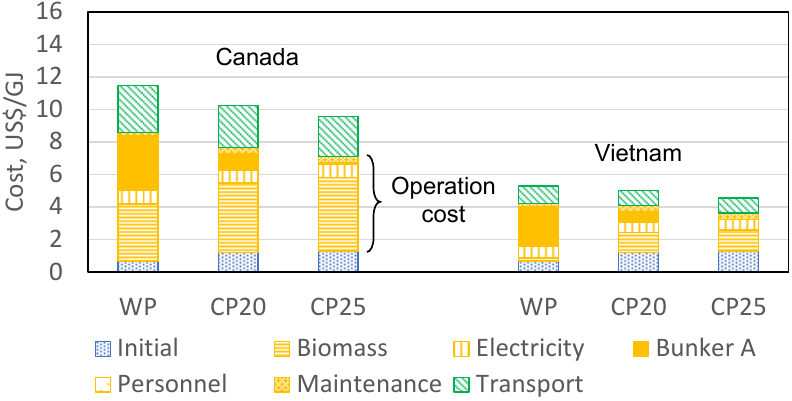
Figure 4. Economic efficiency of WP and CP at the port of import in Japan.